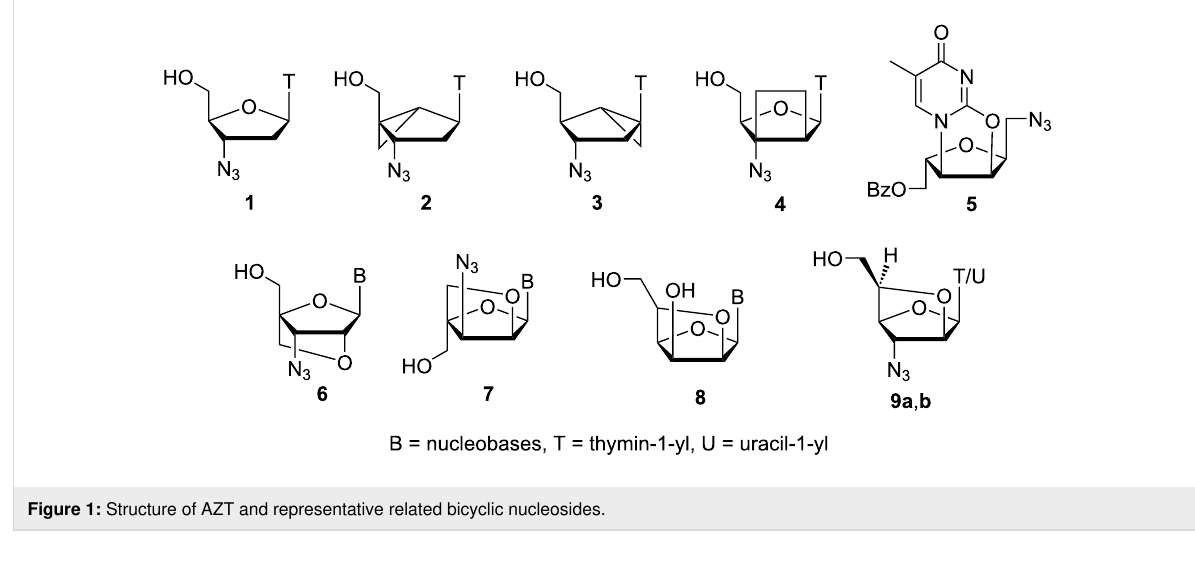
Figure 1: Structure of AZT and representative related bicyclic nucleosides.